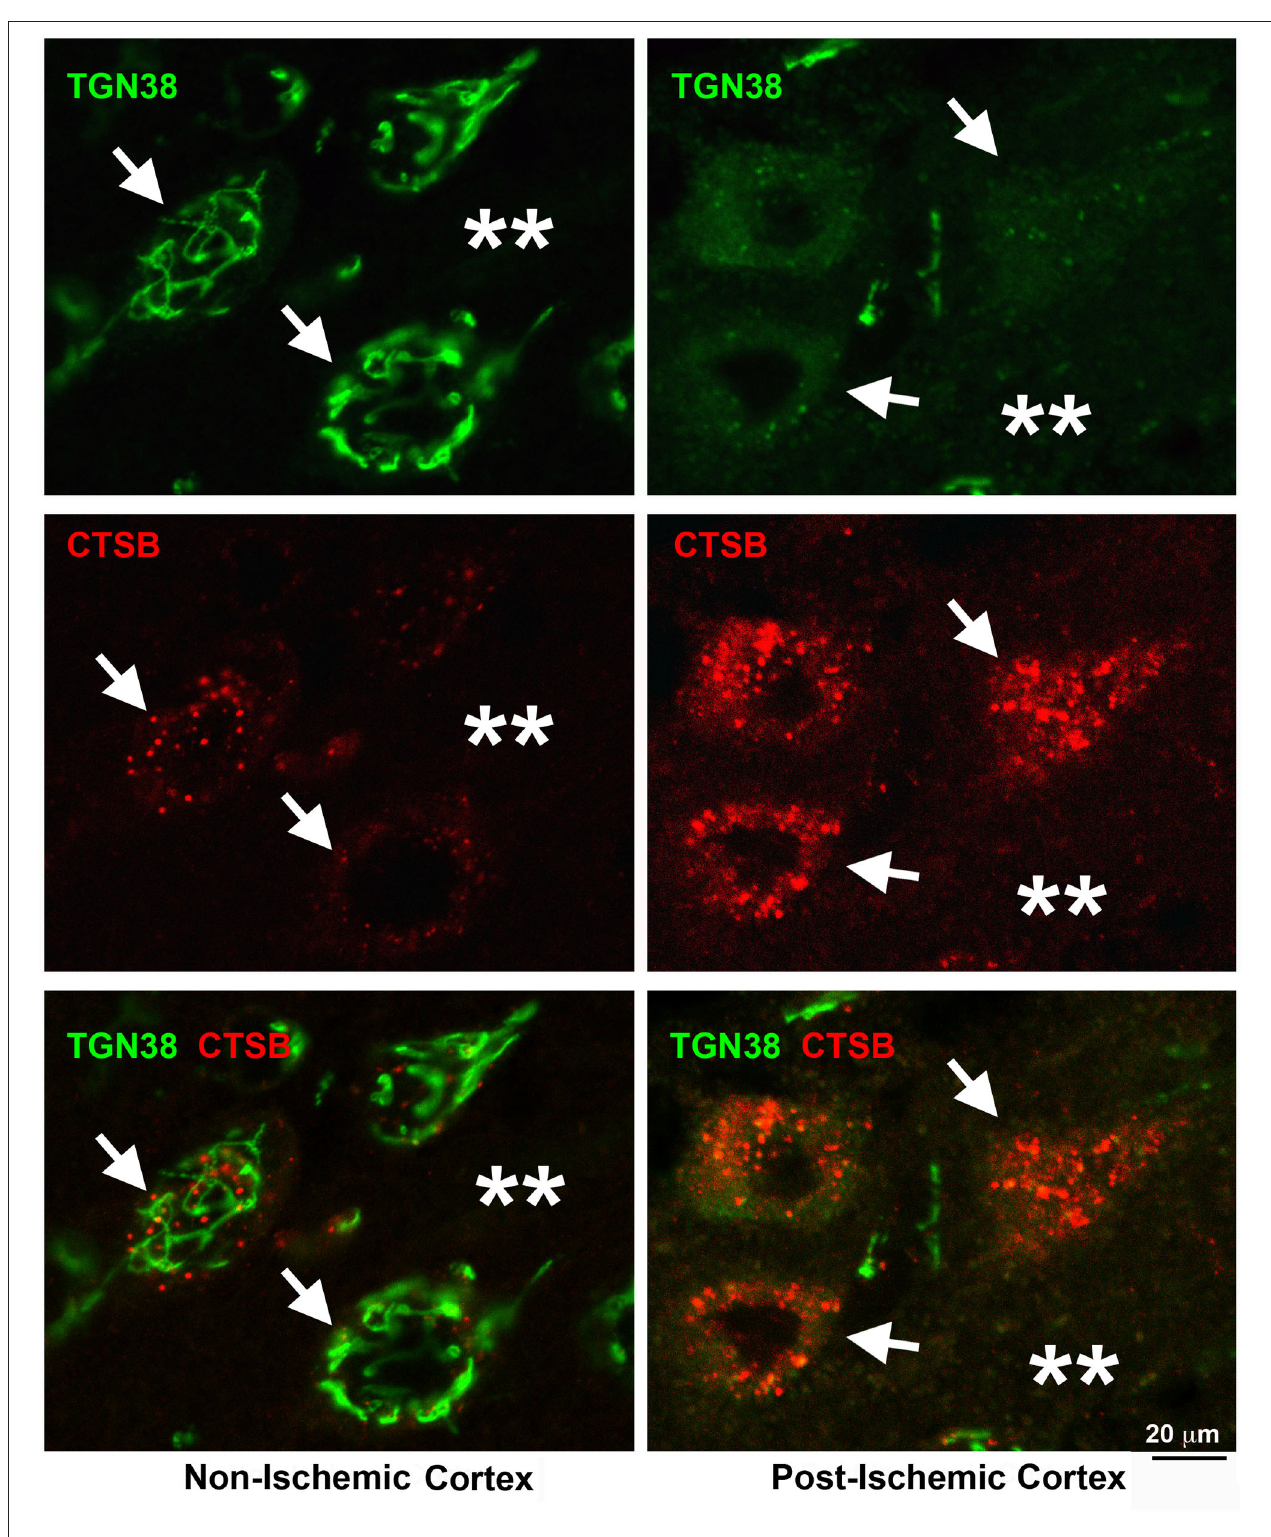
FIGURE 4 | Confocal imaging of neuronal Golgi fragmentation after stroke. Brain section obtained from a rat subjected to 2h of MCAO followed by 24h of reperfusion, double-labeled with TGN38 (green) and CTSB (red) antibodies, and examined by confocal microscopy. Left panels display the contralateral non-ischemic cortex; Right panels show the ipsilateral post-ischemic cortex. Upper row : TGN38 immunolabeling; Middle row : CTSB immunolabeling; Lower row: TGN38 (green) and CTSB (red) double-immunolabeling. Arrows point to neuronal soma; and stars denote the immunostaining outside neuronal soma.